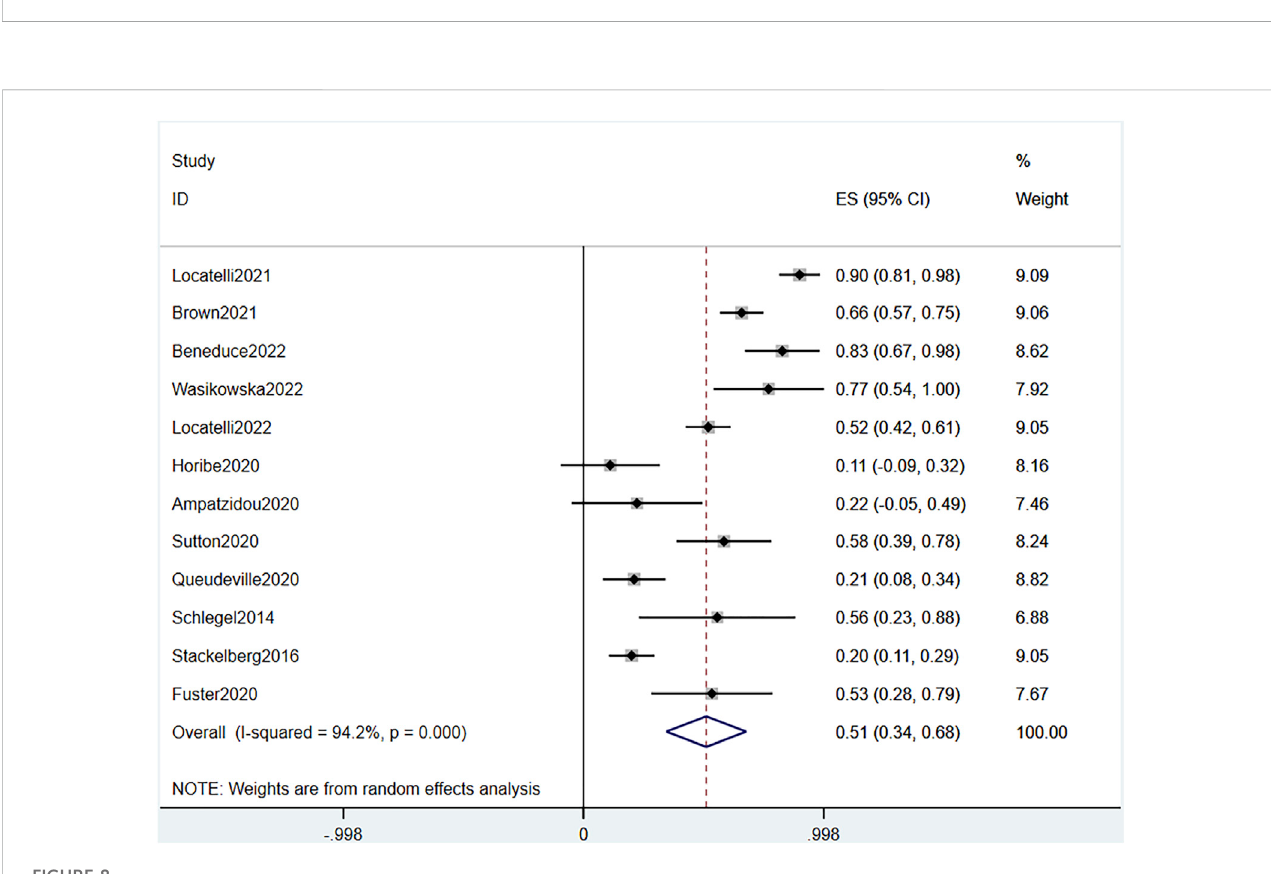
FIGURE 8 Forest plot of MRD (single-arm studies). MRD, minimal residual disease; 95% CI, 95% con fi dence interval; ES: Effect Size. The size of the rectangle at the center of the horizontal bar is proportional to the weight of the given study. The diamond at the bottom indicates the pooled ES.